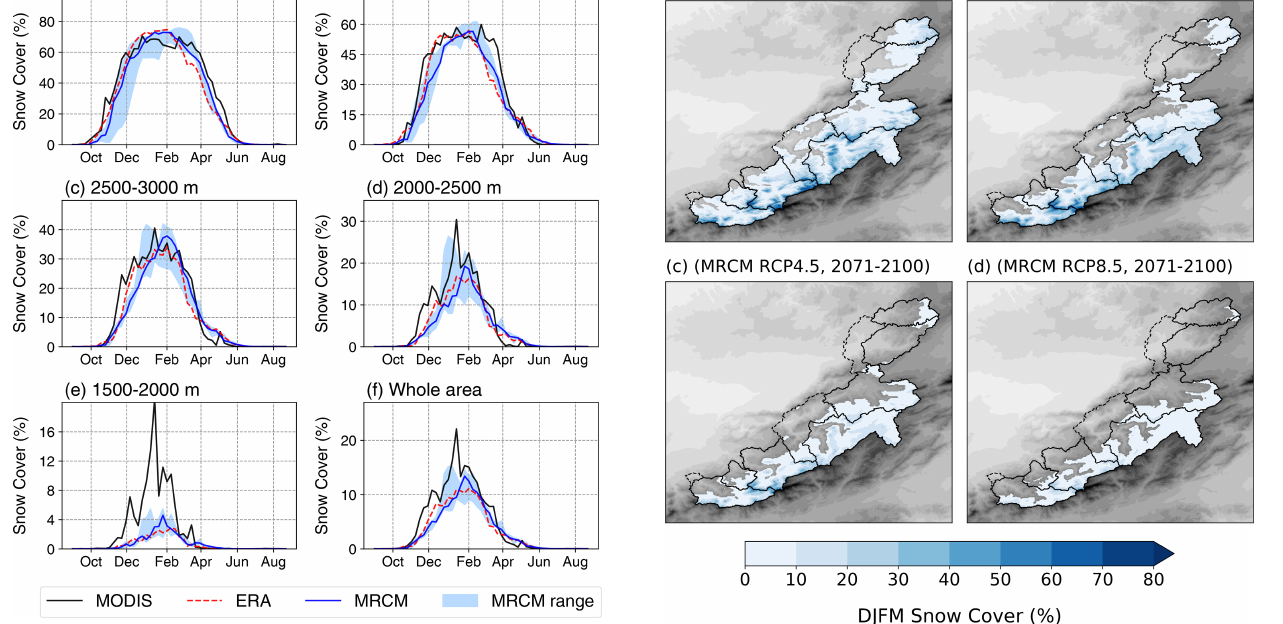
Figure 6. Mean December–March (DJFM) fractional snow cover (%) over the basin in (a) MODIS (2000–2010) data and (b–d) three-GCM average under the (b) historical (1976–2005), (c) RCP4.5 (2071–2100) and (d) RCP8.5 (2071–2100)